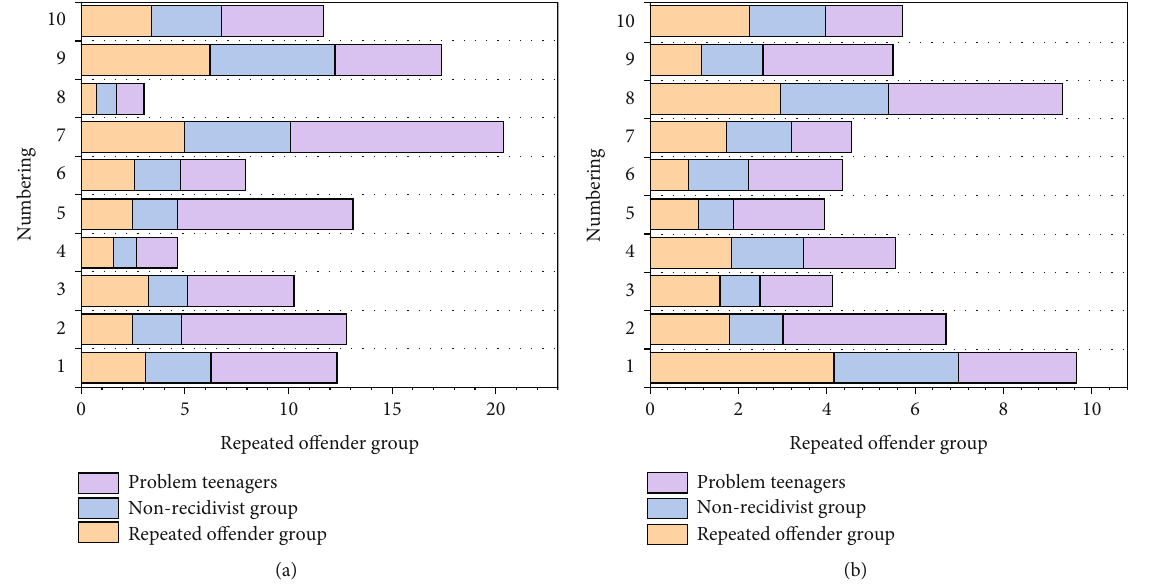
Figure 4: OR values of di ff erent groups of adolescents in VIO and ANT scales compared with normal youths ((a) OR values in VIO scale and (b) OR values in ANT